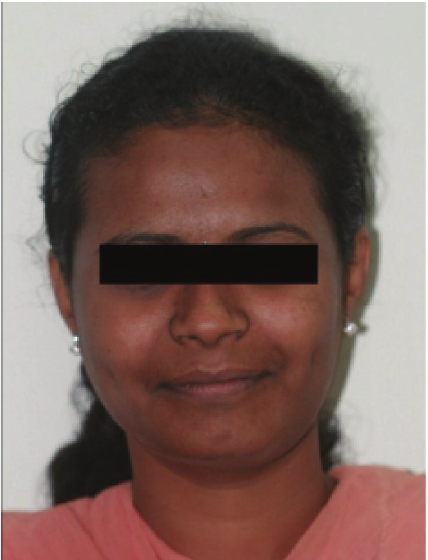
Figure 1: Extraoral photograph showing bilateral asymmetry of the face.